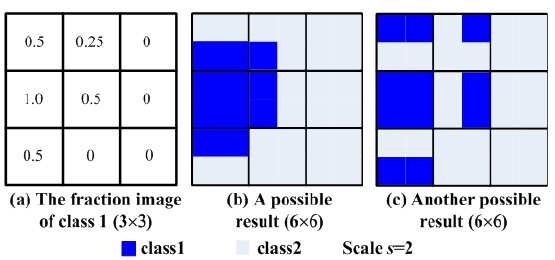
Figure 1. An example of sub-pixel mapping (3 × 3